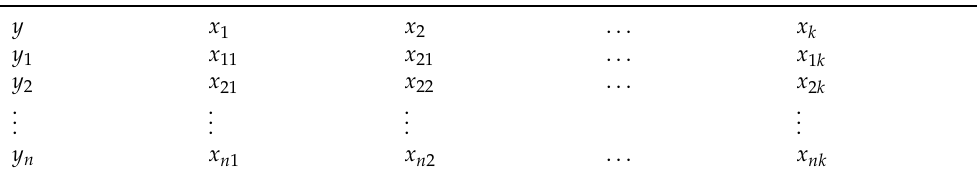
Table 2. Data for multiple linear regression